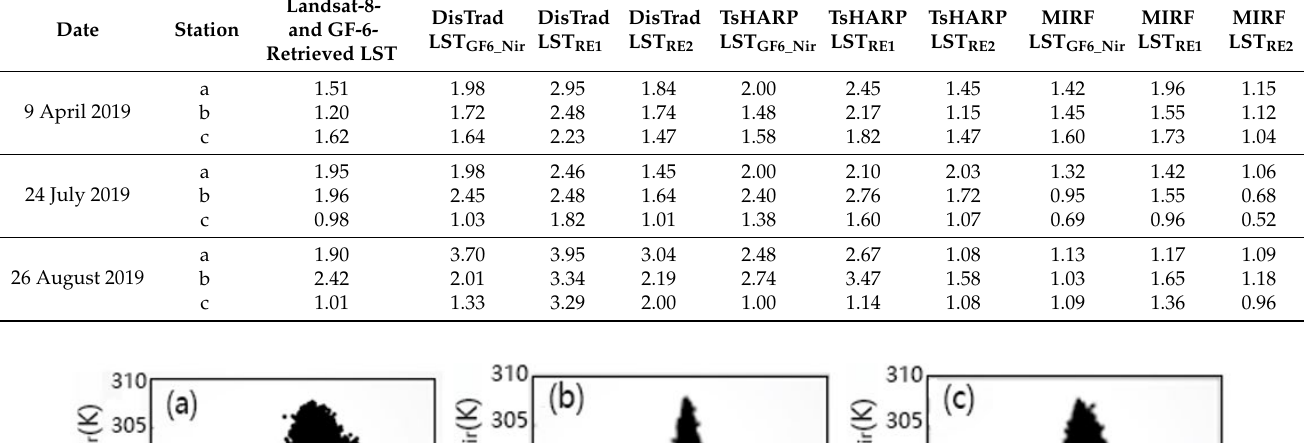
Table 5. Bias of downscaling results and ground observation data (in K).